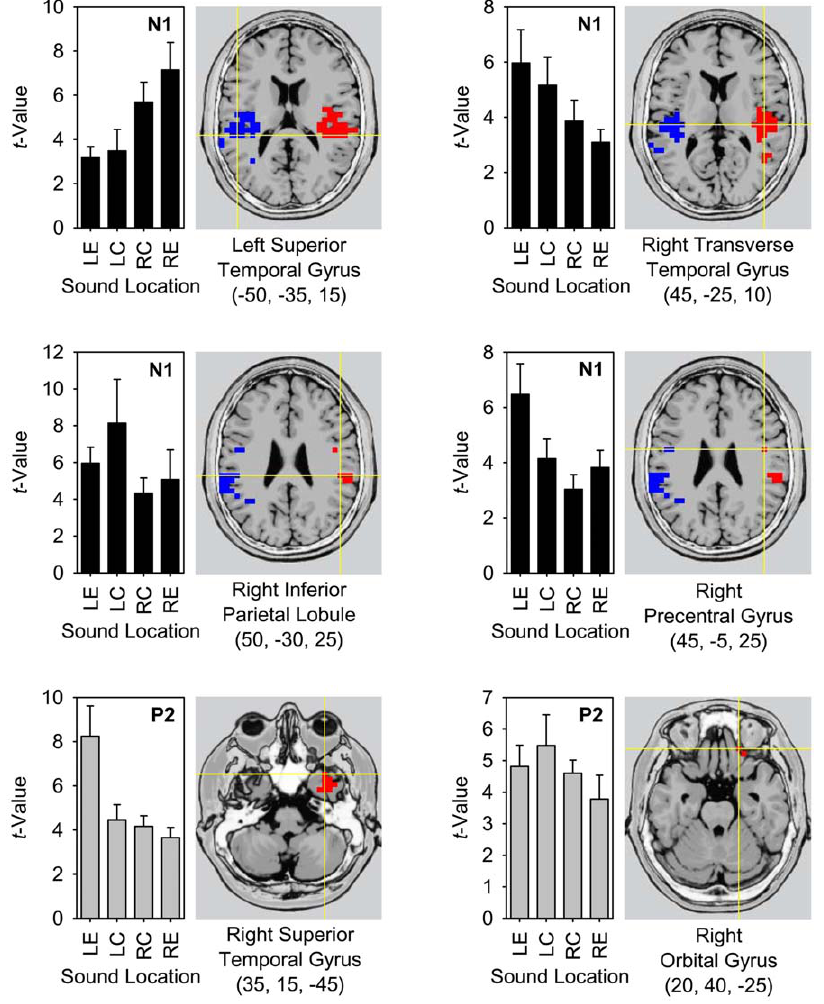
Figure 6. Significant variation of activation as a function of location for six examplary areas, as revealed by different contrasts either at the time of the N1 (black bars) or at the time of the P2 (gray bars). For the voxel with maximum activation in each of the areas (coordinates taken from Table 3), the plots show the mean t -values as a function of sound location (error bars, standard errors across subjects), resulting from contrasts of activations with a 40-ms prestimulus period of silence (as in Figs. 3, 4). Note that these t -values are based on statistical comparisons of the estimated current densities at a specific sound location versus baseline, whereas the images are based on comparisons between estimated current densities for different sound locations. Coordinates given in brackets indicate X , Y , Z MNI coordinates of the maximum activation, as are shown in horizontal slices. Areas are as in Table 3 and Fig. 5. doi:10.1371/journal.pone.0025146.g006 PLoS ONE |